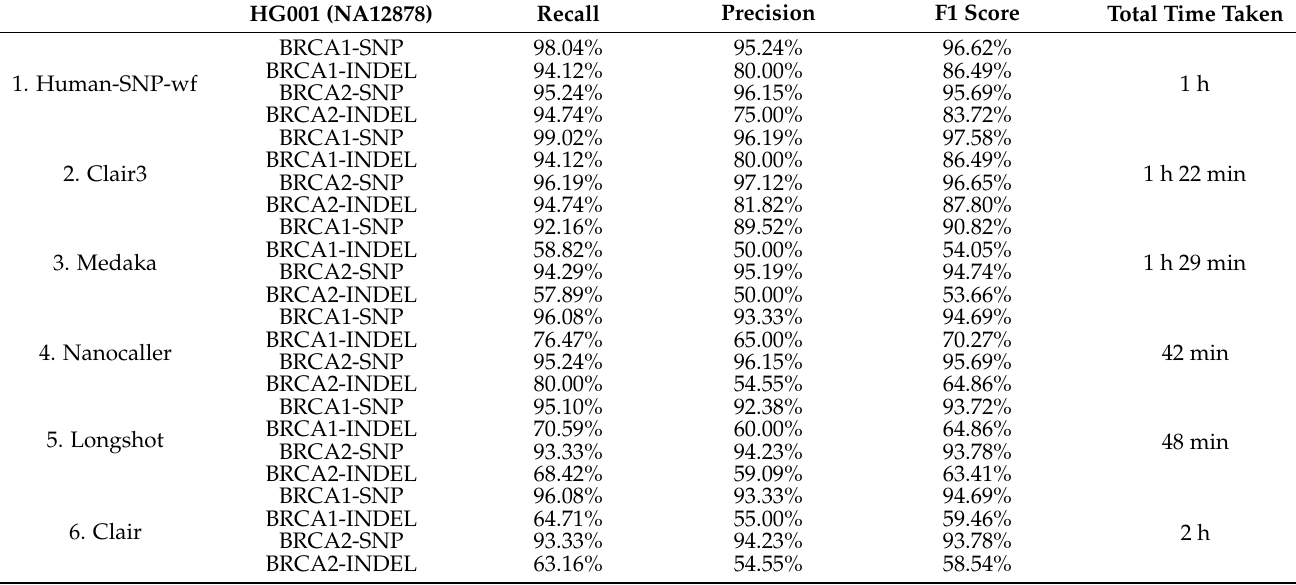
Table 5. Summary for the benchmarking output for HG001 with 6 different variant callers, highlight- ing the recall, precision, and